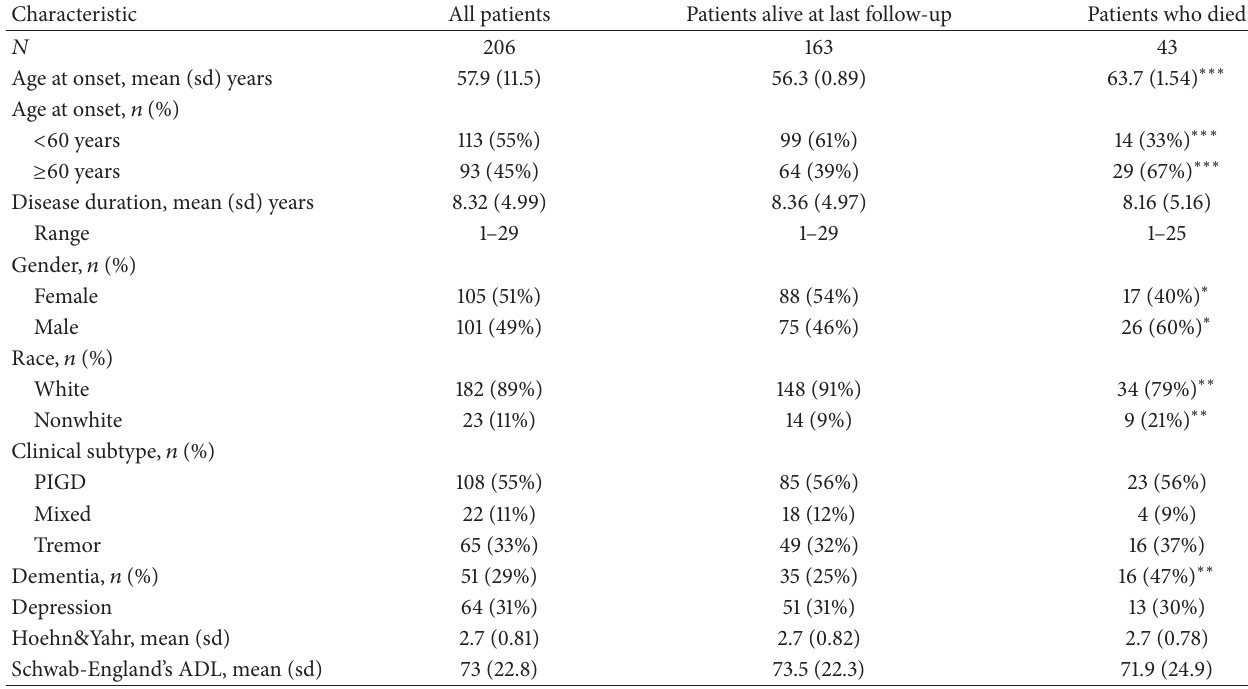
Table 1: Clinical characteristics of patients with PD at the time of the first evaluation.